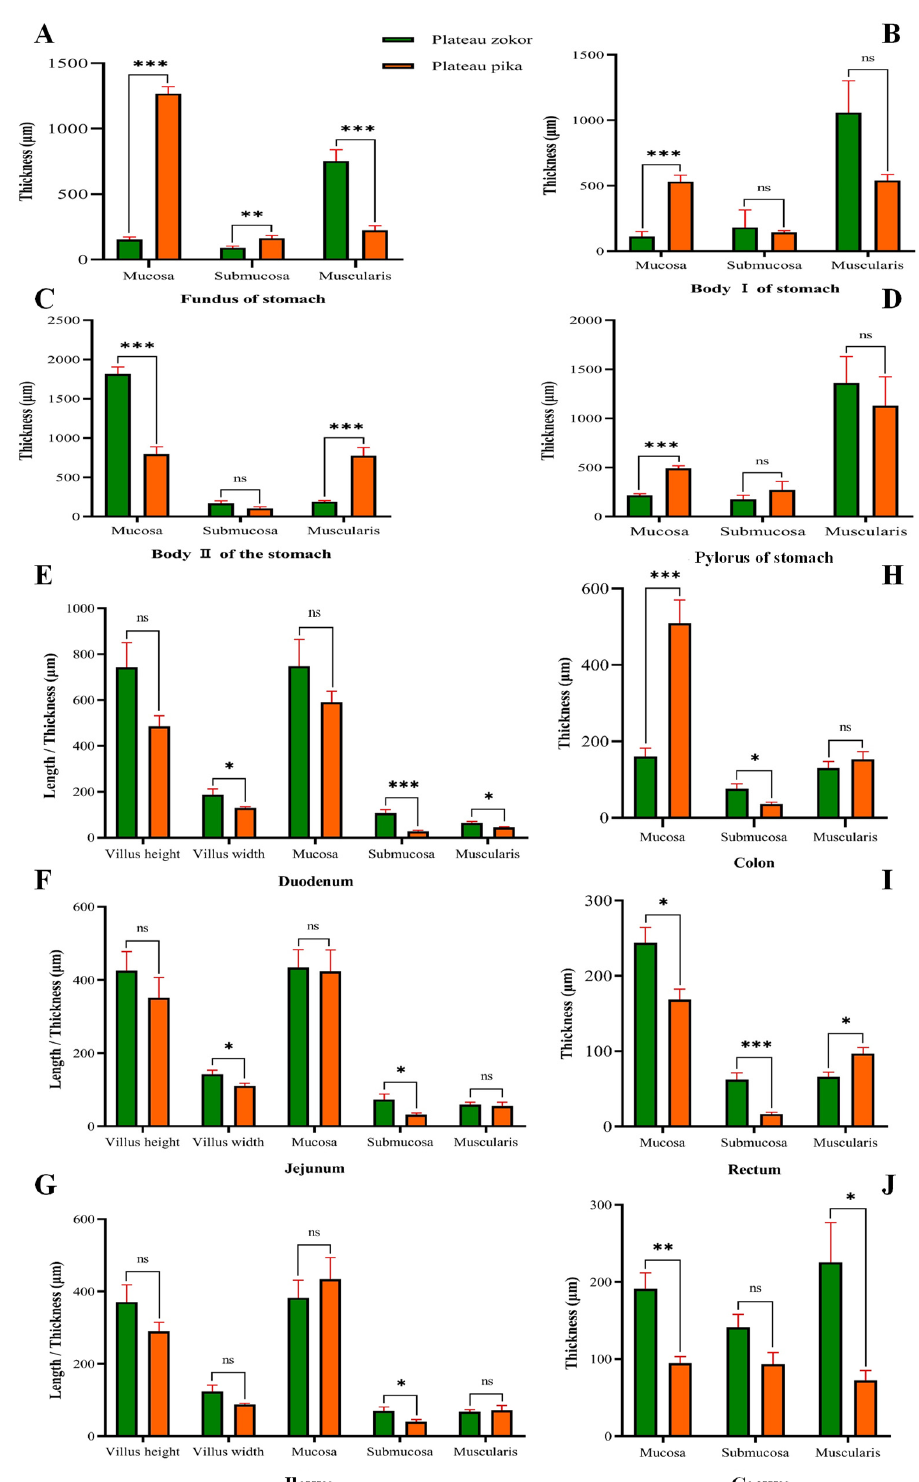
Figure 8. Differences in the histological structure of the various layers of gastrointestinal organs between plateau zokor and plateau pika. ( A – J ) Stomach, (( A – D ) fundus, corpus I, corpus II, and pylorus of stomach), duodenum, jejunum, ileum, colon, rectum, and cecum, respectively. * indicates significant difference ( p < 0.05); ** indicates an extremely significant difference ( p < 0.01); *** indicates an extremely significant difference ( p < 0.001); ns indicates an insignificant difference.